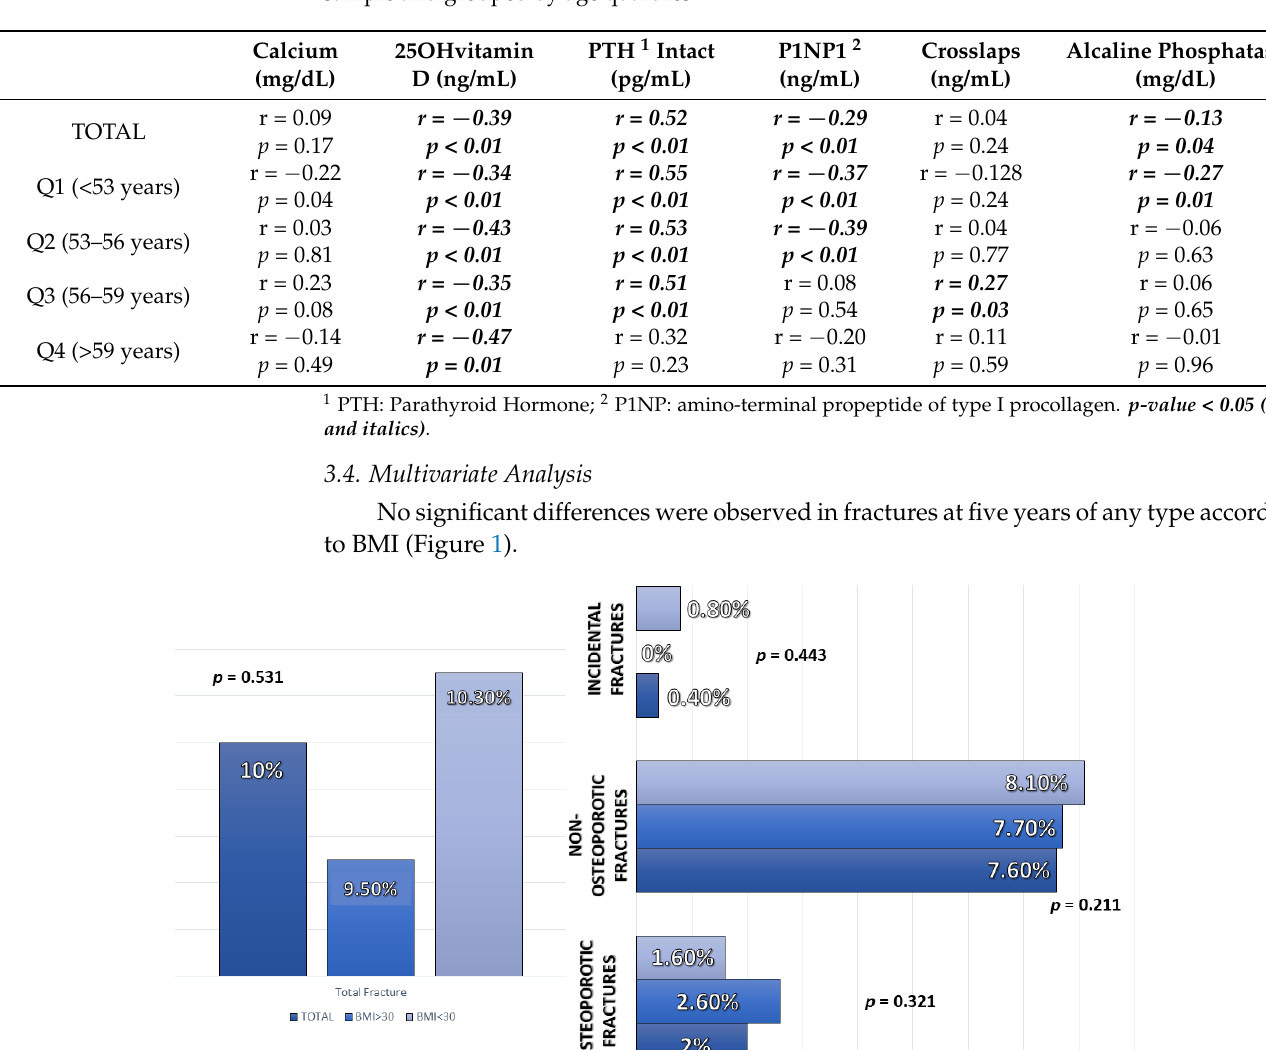
Table 3. Correlation analysis of body mass index (BMI) with bone metabolism parameters in total sample and grouped by age quartiles.